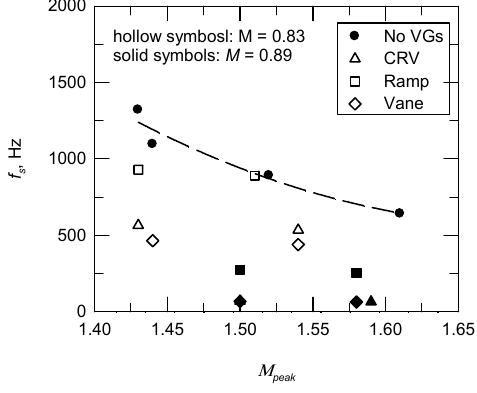
Figure 16. Shock zero-crossing frequency with/without MVGs. Gonsalez and Dolling [32] showed that the peak f s is nondimensionalized in the form of the Strouhal number with the intermittent region length as the characteristic length scale, whose value lies within the range of 0.01–0.03 for compression ramp and blunt-fin interactions. L is used as the characteristic length scale in this study. The Strouhal number St (= f s L / U p ) is determined, as shown in Figure 17, where U p is the peak velocity. The values range from 0.12 to 0.09 for the baseline case, when there is an increase in M peak . The presence of MVGs stabilizes the shock, so the value of St is smaller, less than 0.06. Figure 17. St with/without MVGs. Therefore, shock oscillation is damped, particularly for M = 0.89 ( St <